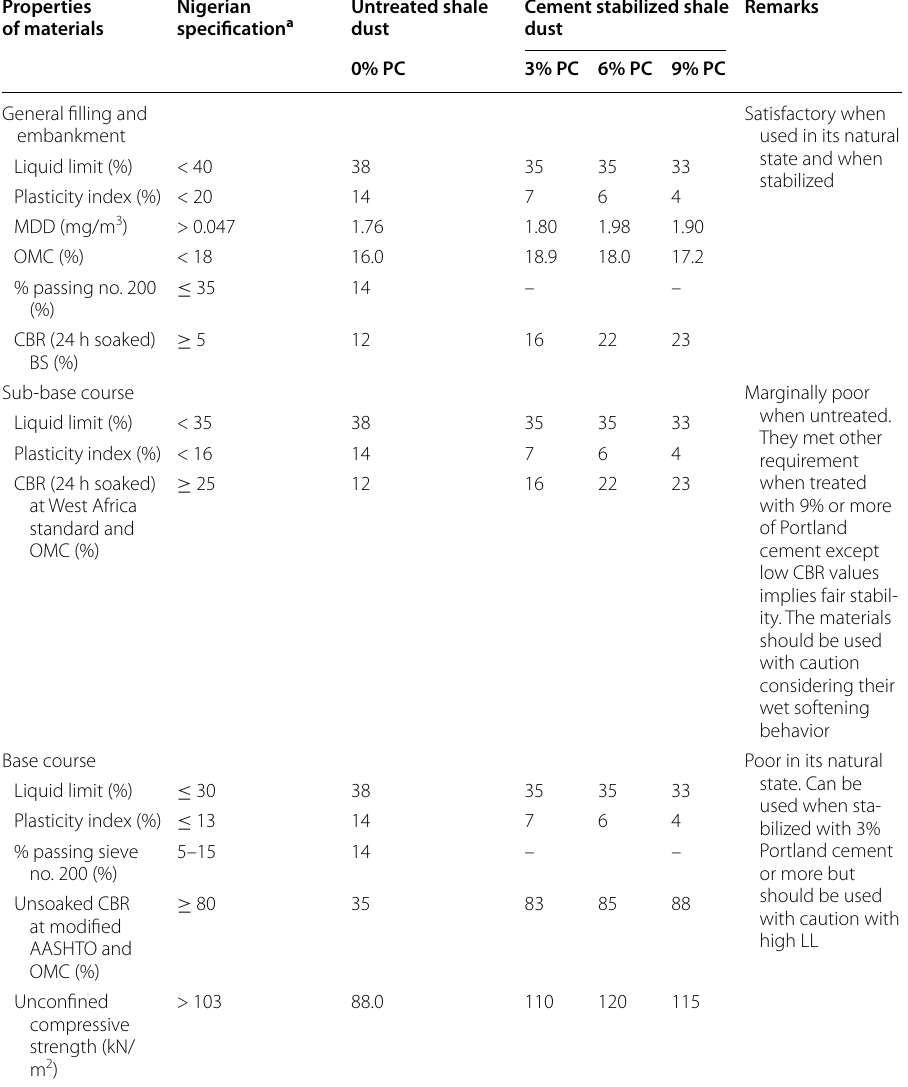
Table 5 Properties of cement-treated materials with Nigerian specifications for